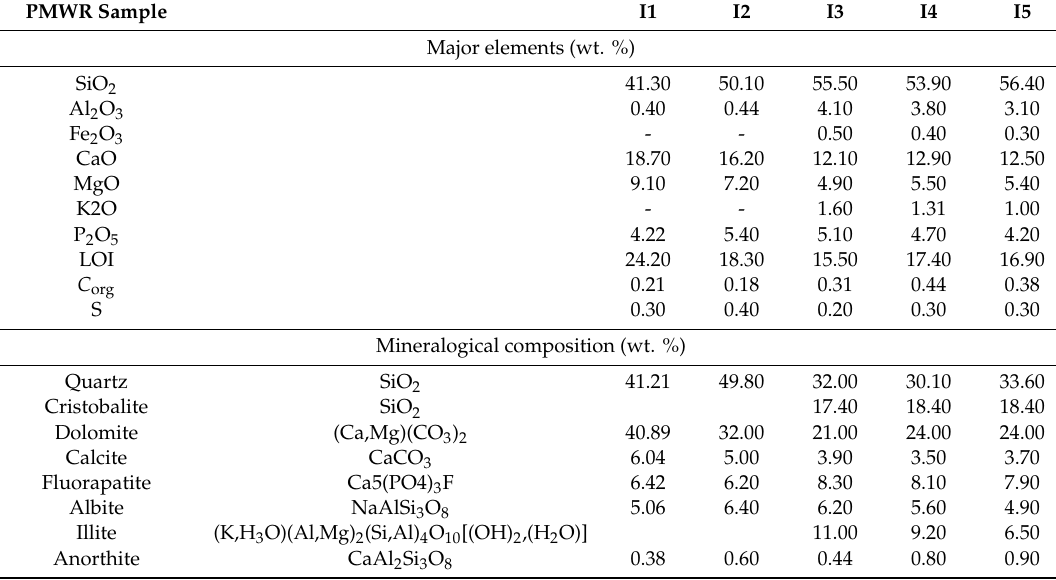
Table 2. Chemical and mineralogical composition of PMWR samples.